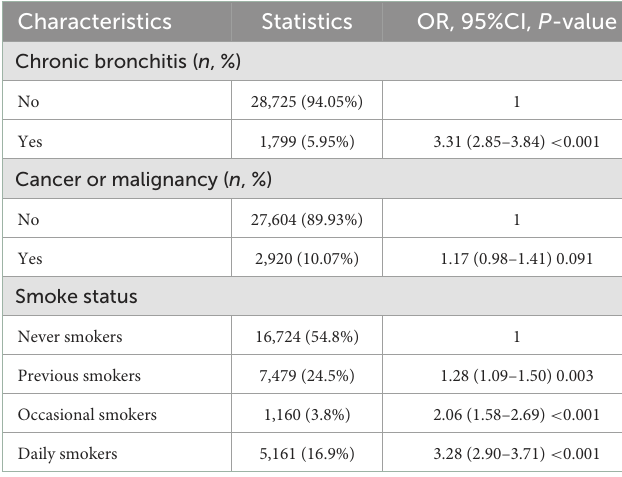
TABLE 2 Univariate analysis of depressive symptoms in the study population based on smoking